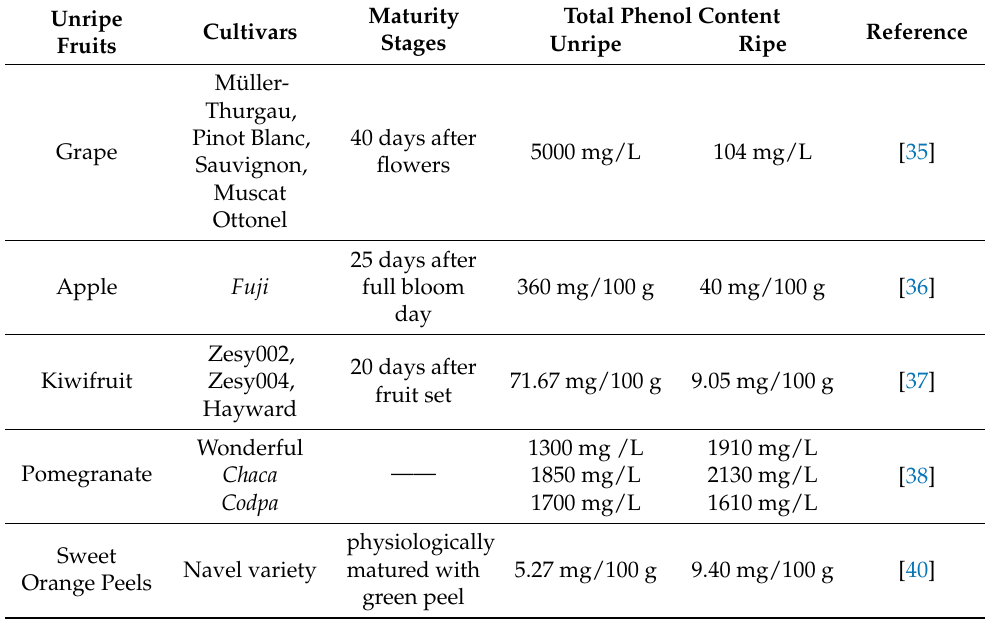
Table 1. Comparison of total phenol content in unripe and mature